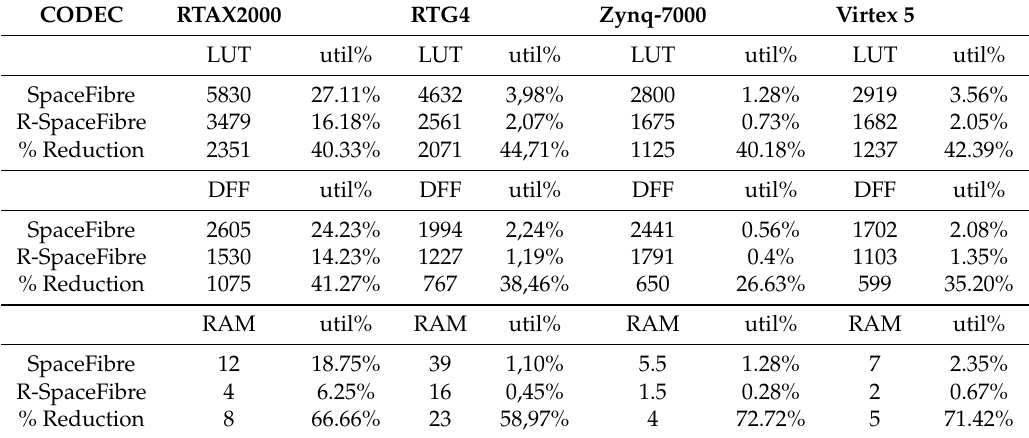
Table 2. SpaceFibre vs. R-SpaceFibre resources utilisation on Microsemi RTAX2000 and RTG4.